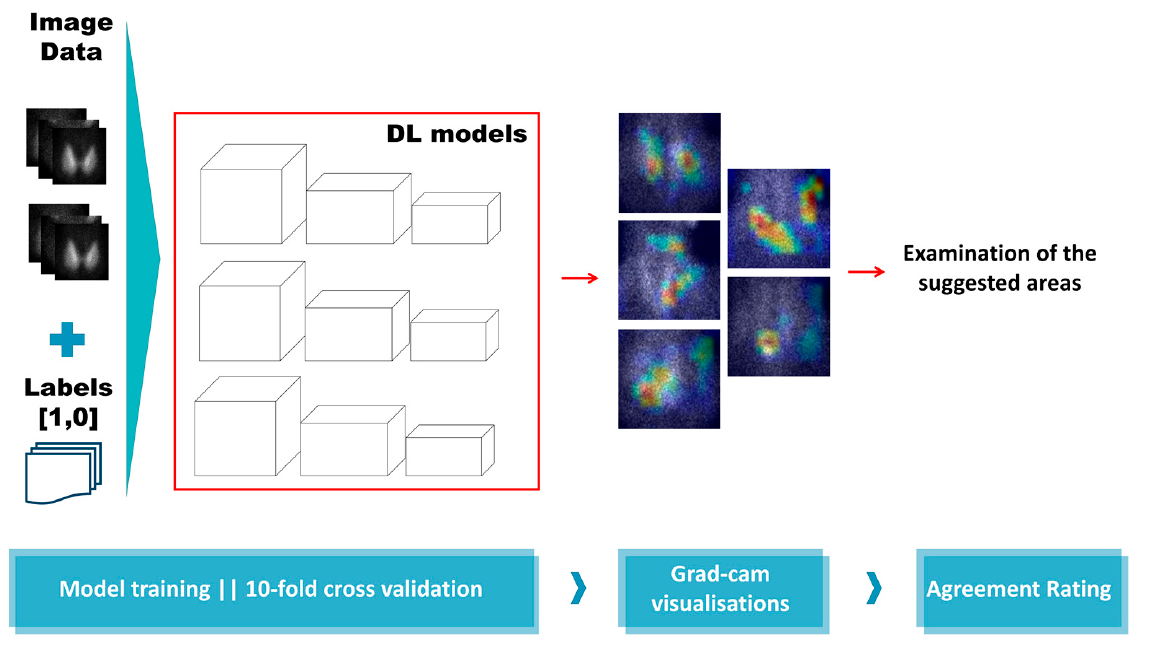
Figure 3. Experiment overview.